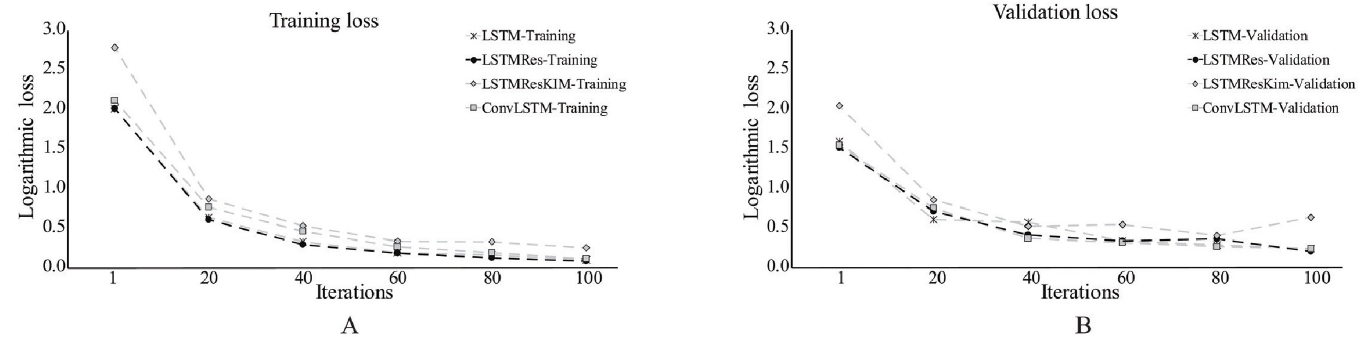
Fig 3. Training and validation errors of LSTM, LSTMRes, LSTMResKim, and ConvLSTM. From the start until the end of learning, LSTMResKim had lower performance than the others.